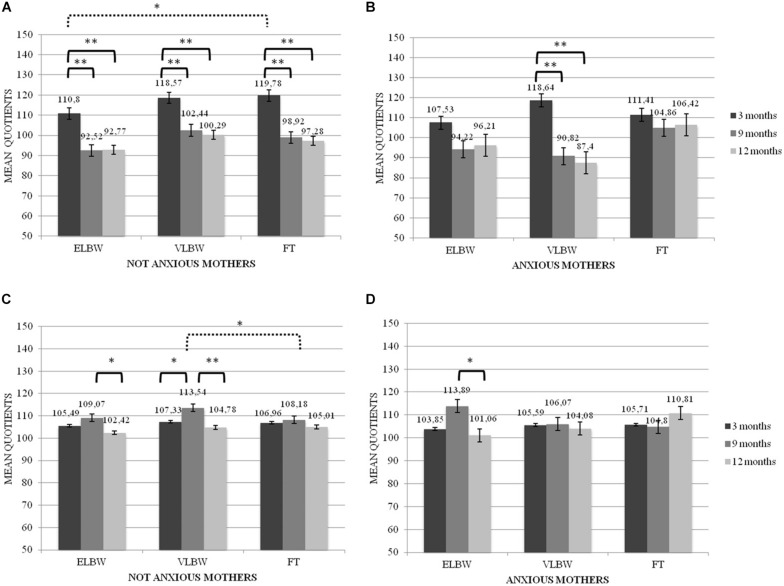
Locomotor and Hearing and Language quotients according to the interaction between birth weight, maternal anxiety and tune of assessment. *p < 05; **p < 0.005. (A) Locomotor mean Quotients in Not Anxious group, (B) Locomotor mean Quotients in Anxious group, (C) Hearing and Language mean Quotients in Not Anxious group, (D) Hearing and Language mean Quotients in Not Anxious group. Continue line denotes within group comparison, dotted line between group comparison.